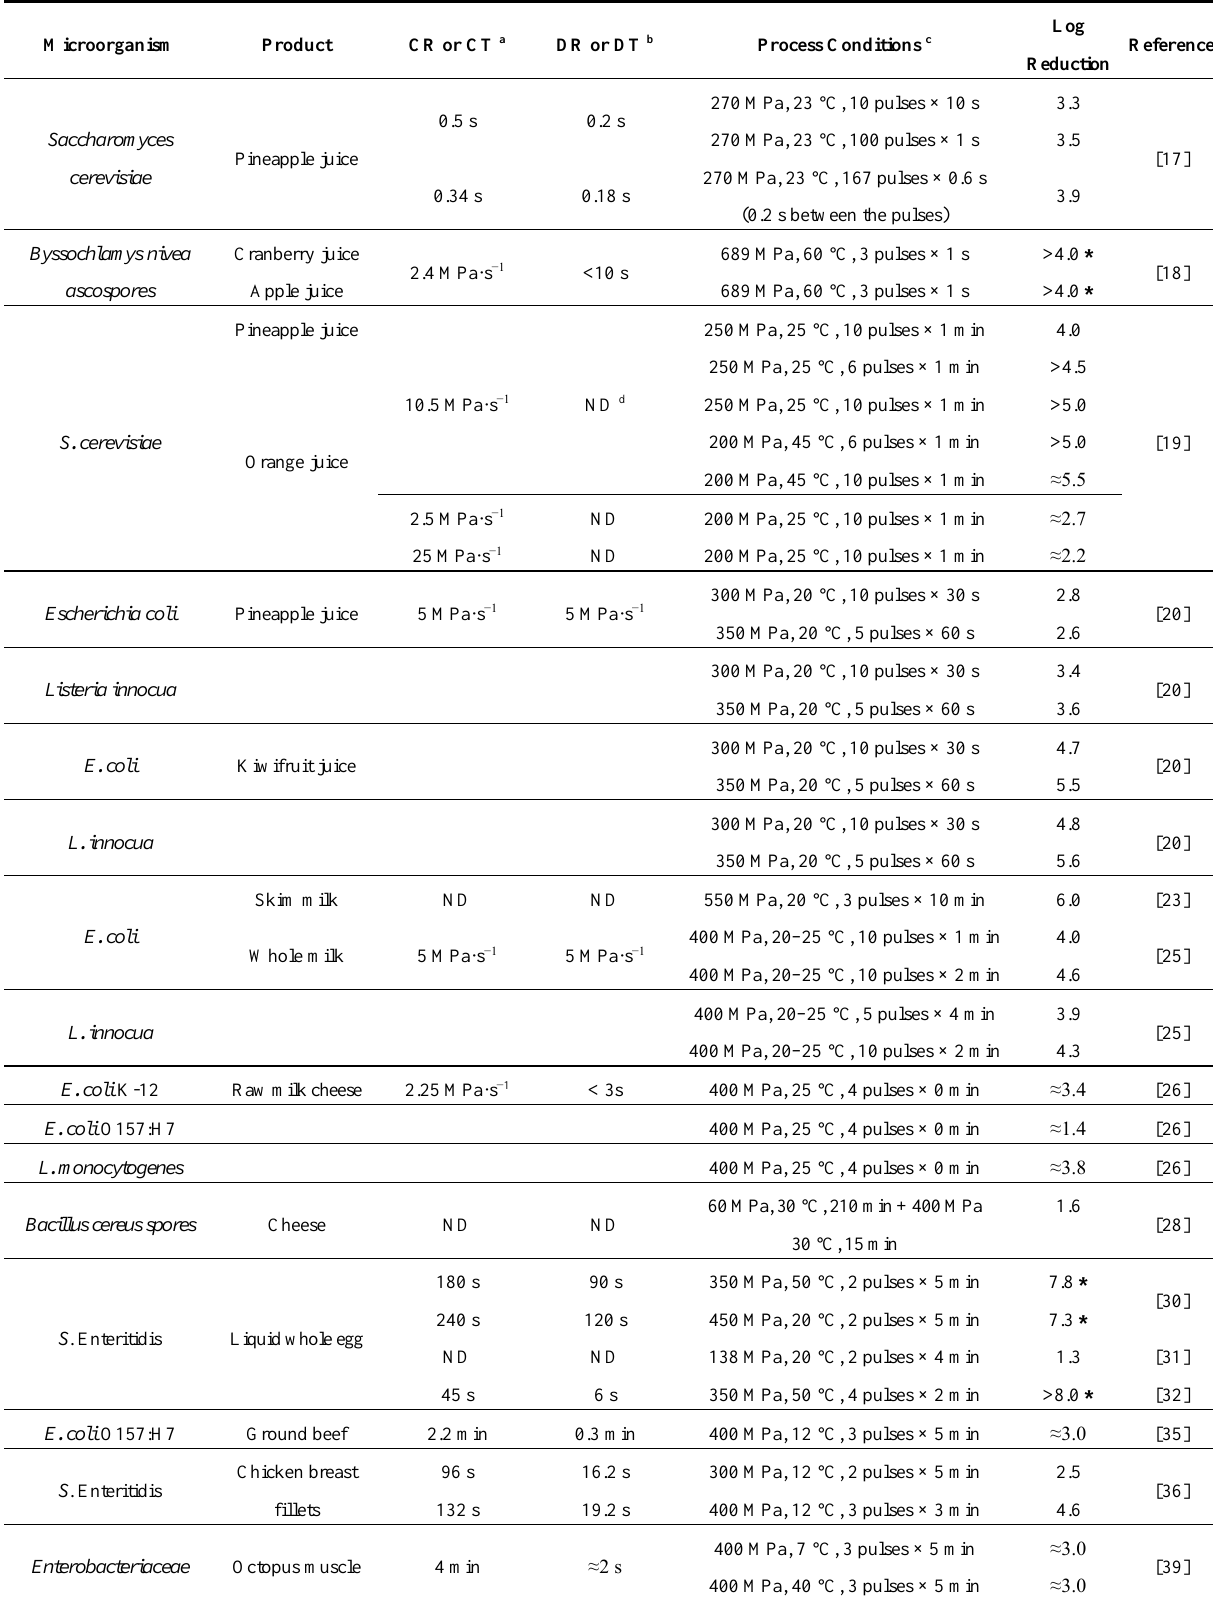
Table 1. Summary of multi-pulsed high hydrostatic pressure (mpHHP) inactivation of microorganisms in